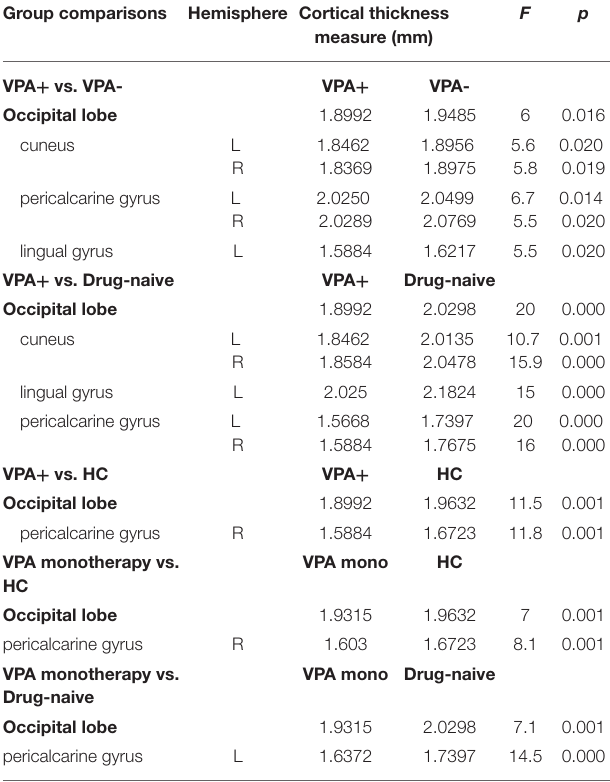
TABLE 2 | Significant cortical thickness analyses